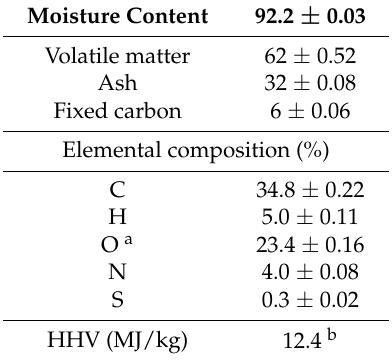
Table 1. Proximate and ultimate analysis of tomato plant wastes (TPW) (wt% on Dry Basis).